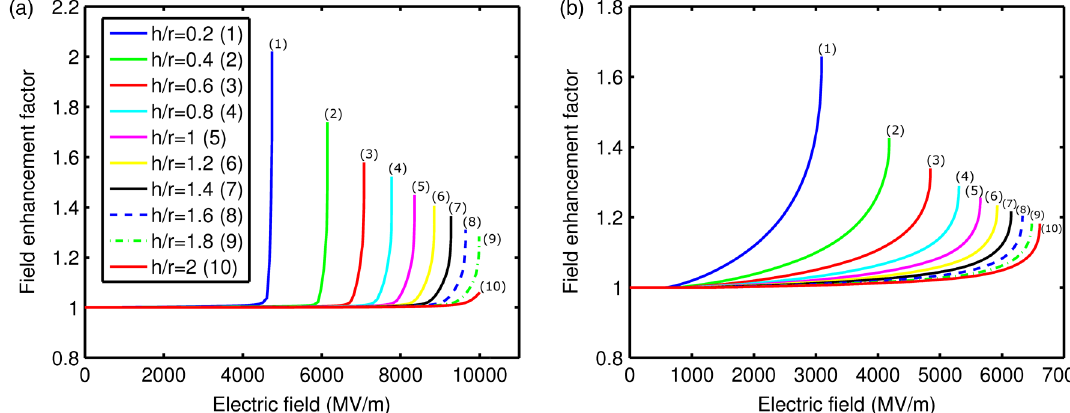
FIG. 6. Field enhancement factor depending on the external electric field on the stainless steel (a) and the annealed copper (b)